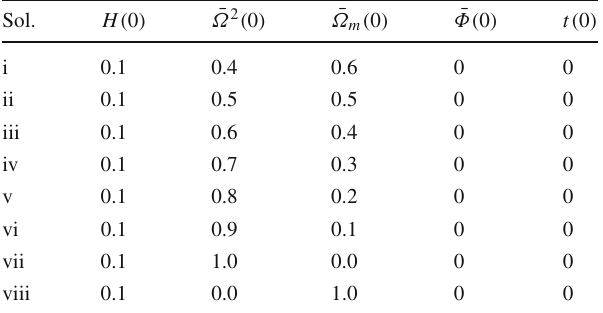
Table 4 Eight initial data sets for the simulation of full system (44) with ¯ Σ = 0 and time-averaged system (98) if γ (cid:8)= 1 or (103) if γ = 1 forflatFLRWmetric( k = 0)aredisplayed.Allinitialconditionssatisfy ¯ Ω 2 ( 0 ) + ¯ Ω ( 0 ) = 1 m Sol. H ( 0 ) ¯ Ω 2 ( 0